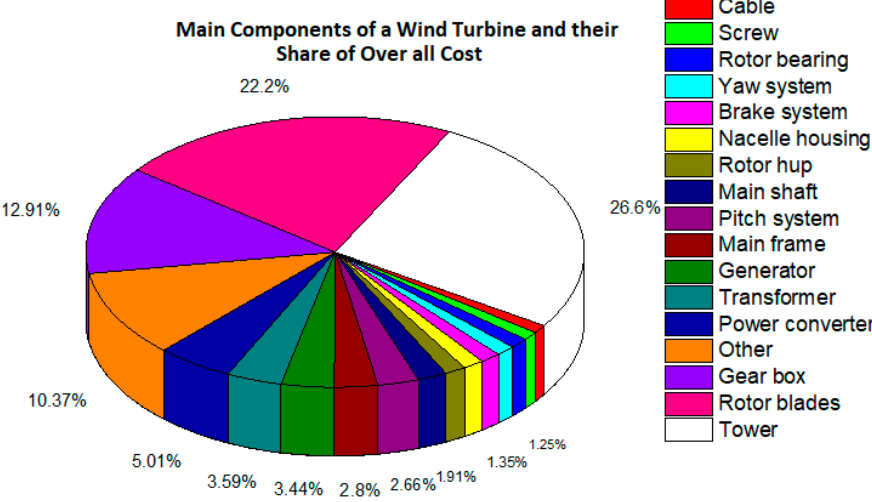
Figure 5. Main components of a wind turbine and their share of the overall cost [9].